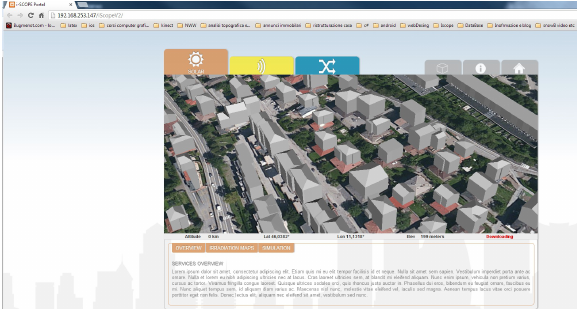
Figure 6 The web client application showing the LoD2 city Model of buildings superimposed to the Digital Terrain